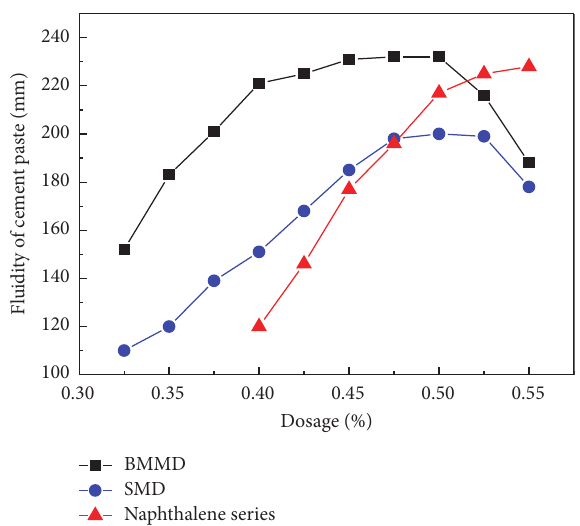
Figure 5: Effect of the water-reducing agent added on the fluidity of cement